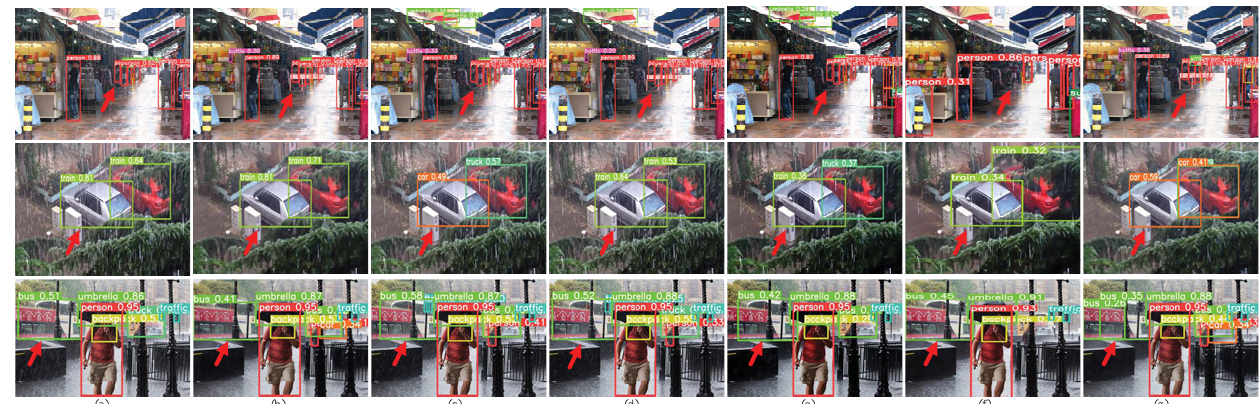
Figure 10. The visualization results of object detection by YOLOv5 for images from different deraining methods. ( a ) Rain image. ( b – f ) Tesults from RESCAN [12], MPRNet [16], PCNet [17], ReMAEN [32], DID-MDN [40]. ( g ) Object detection result from our method. Please zoom in to see clearly and note the red